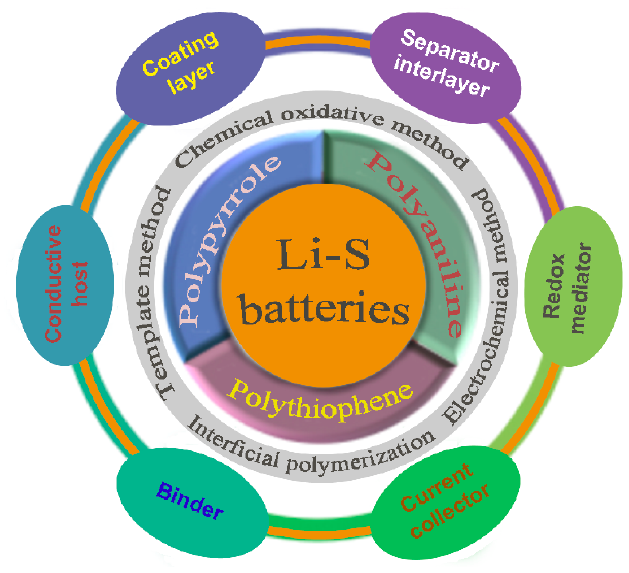
Figure 9. Schematic presentation of the synthesis of conducting polymers and their application in Li-S batteries.